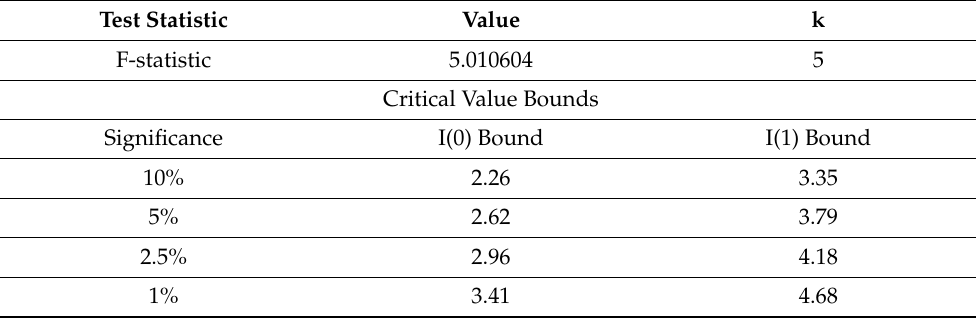
Table 7. ARDL Bounds Testing